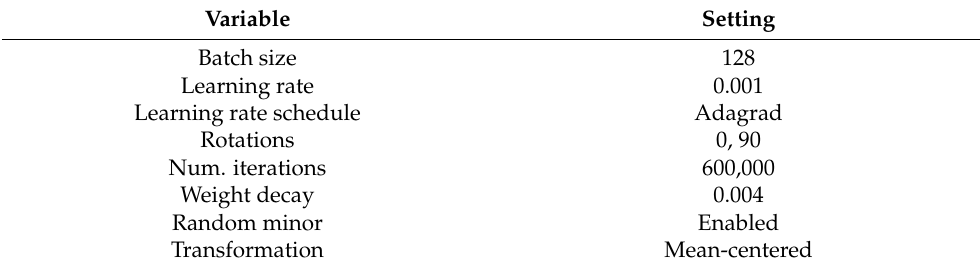
Table 3. AlexNet